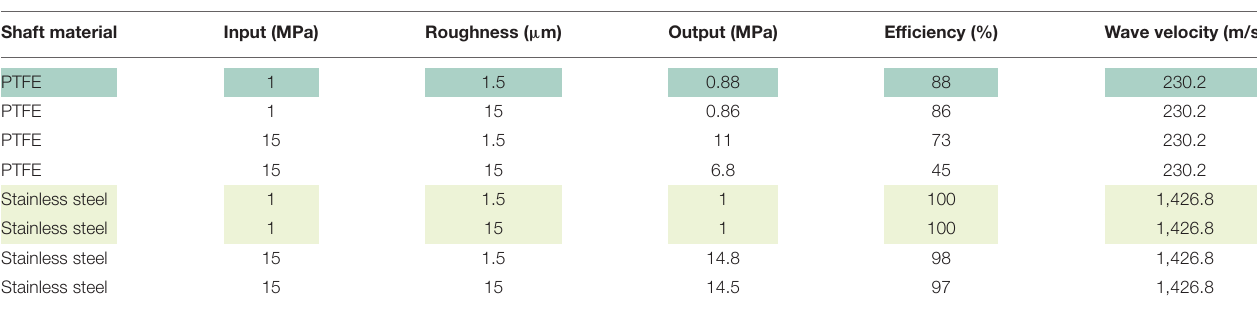
TABLE 1 | COMSOL model